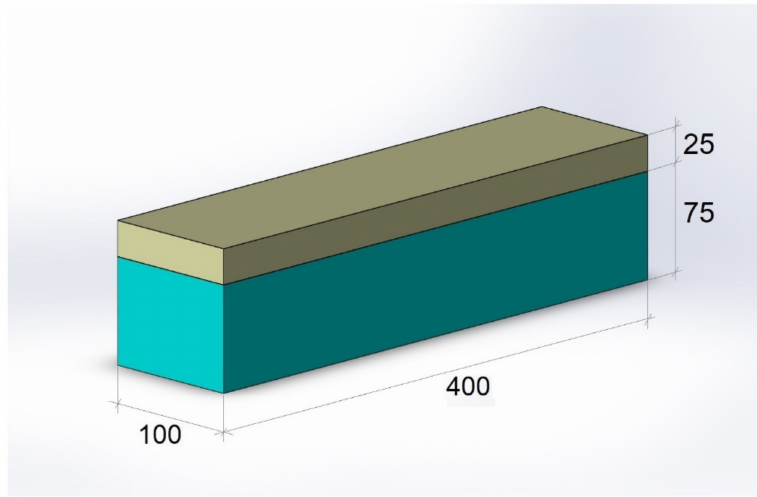
Figure 10. Fiber distribution in the prism of Group A7. Group A8 1. The mould was filled with concrete to the height of 25 mm, then the total amount of